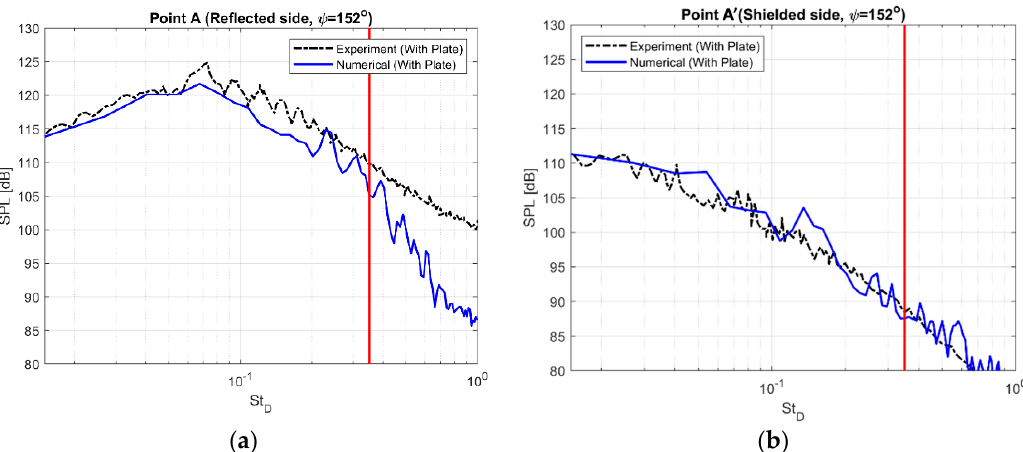
Figure 29. Acoustic spectra of ( a ) reflected, and ( b ) shielded side (no plate). Appl. Sci. 2020 , 10 , x FOR PEER REVIEW